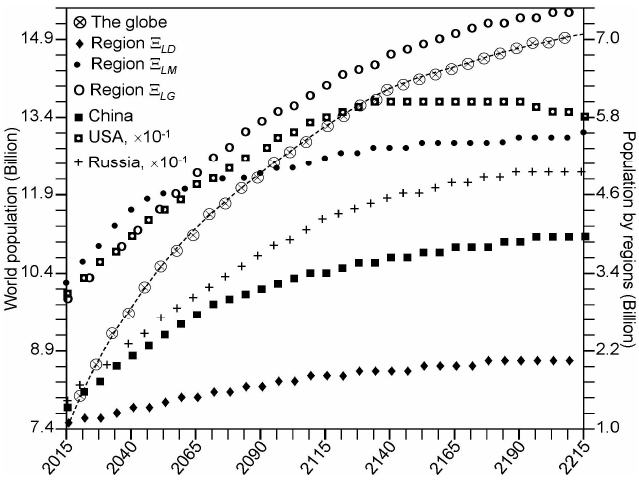
Figure 10. The global and regional population dynamics.